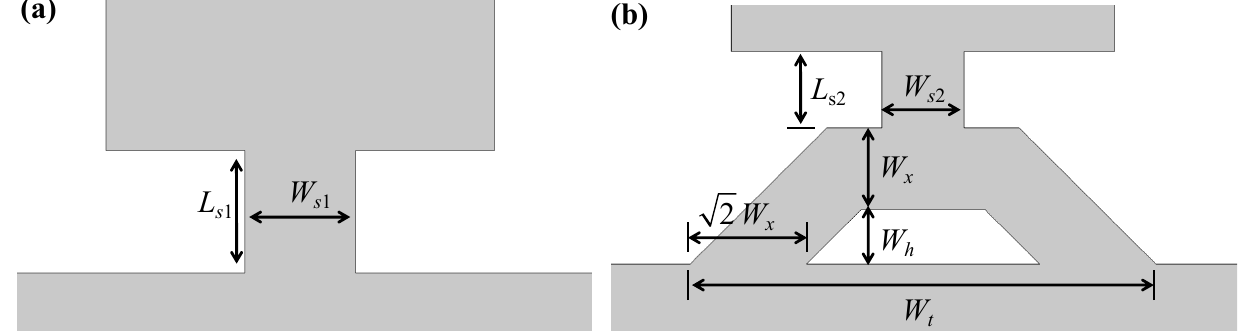
Figure 4. The schematic of the WEM resonators ( a ) with the straight and ( b ) with the combined tether.